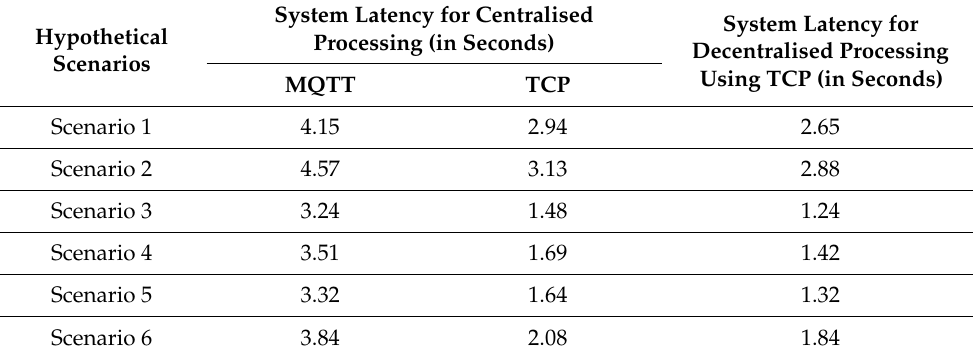
Table 2. Reported latencies for the six earthquake scenarios with three different architectures.